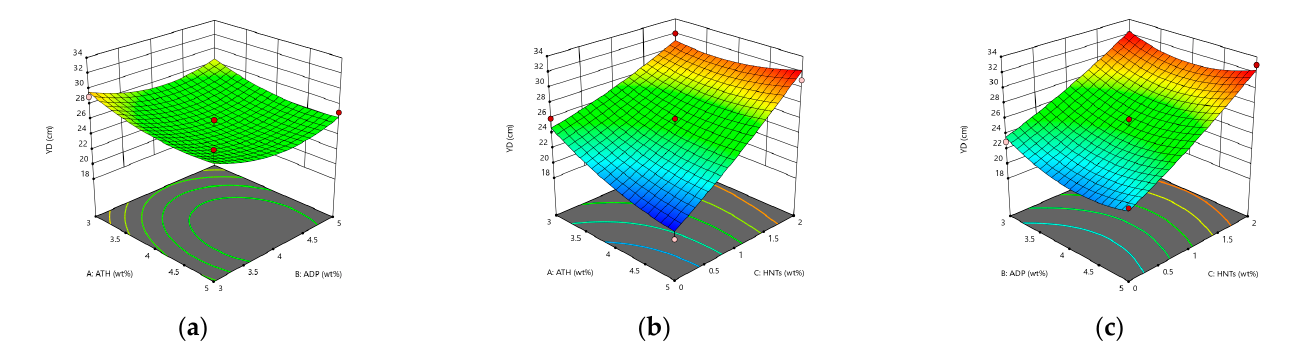
Figure 3. The response surface diagram of the flame retardant system to the change of ductility model: ( a ) Interactive effects of ATH and ADP; ( b ) Interactive effects of ATH and HNTs; and ( c ) Interactive effects of ADP and HNTs.